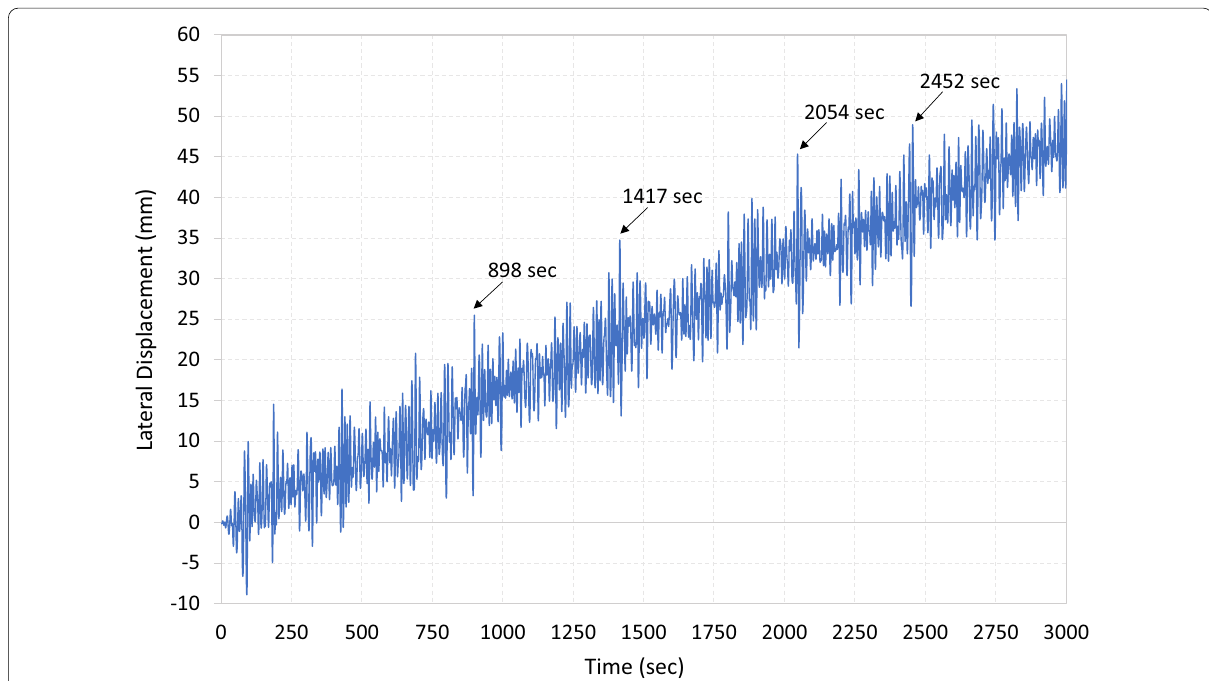
Fig. 11 Time history of the lateral displacement for the pipeline right end for 180 mm concrete coating thickness